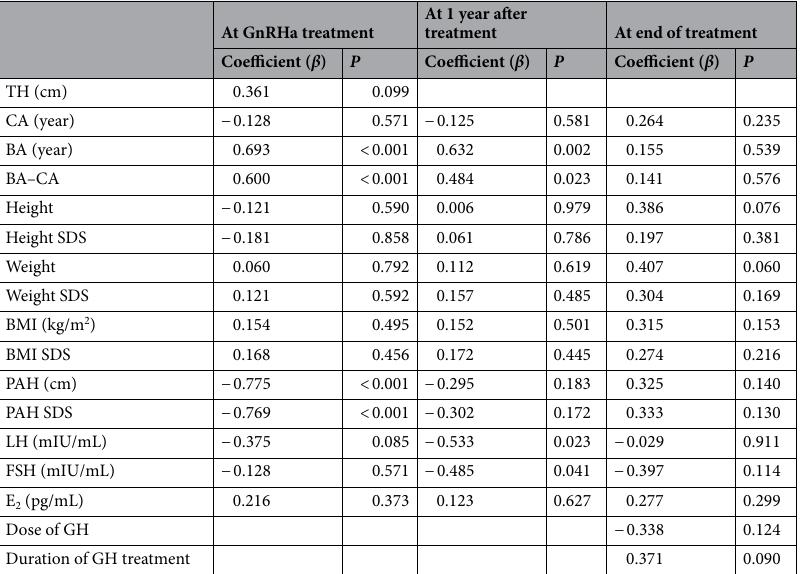
Table 4. Factors influencing height gain in GnRHa + GH treated girls at GnRHa treatment. GnRHa Gonadotropin-releasing hormone agonist, GH Growth hormone, TH Target height, CA Chronological age, BA Bone age, SDS Standard deviation score, BMI body Mass index, PAH Predicted adult height-calculated with advanced table of baley–Pinneau (BP) method; luthenizing hormone, FSH Follicular stimulating hormone; E 2 , estrogen.